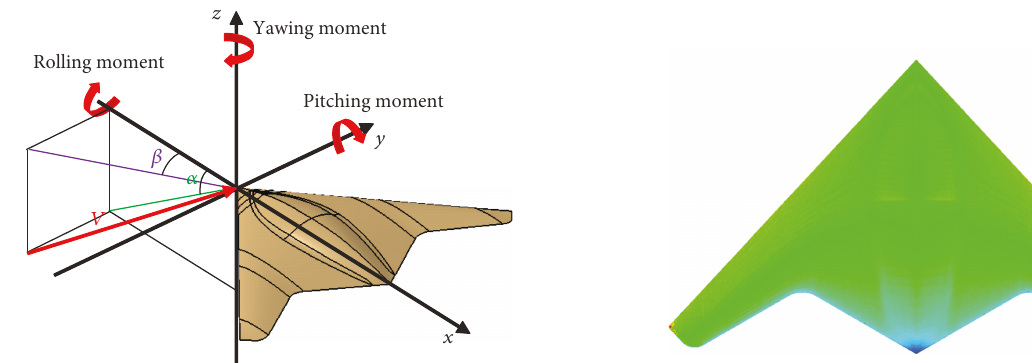
Figure 4: y + contours of upper surface at zero angle of Table 1: Model and fl ow parameters.